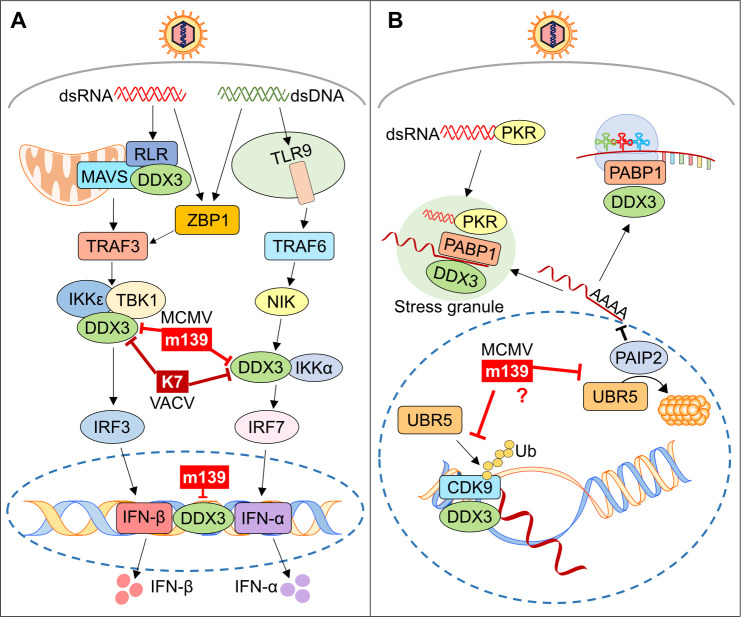
Known functions of DDX3 and UBR5 and their presumed targeting by m139.(A) Functions of DDX3 in IFN activating pathways. MCMV m139 interacts with DDX3 and inhibits IFN-β transcription either by targeting the interaction of DDX3 with IKKε (similar to VACV K7) or by blocking DDX3 binding to the IFN promoter; m139 also inhibits IFN-α induction in a similar way as K7. (B) Functions of DDX3 and UBR5 in RNA transcription, processing, and translation. MCMV m139 co-localizes with DDX3 and UBR5 in the nucleus, suggesting that m139 antagonizes DDX3 and UBR5-dependent functions in the nucleus.